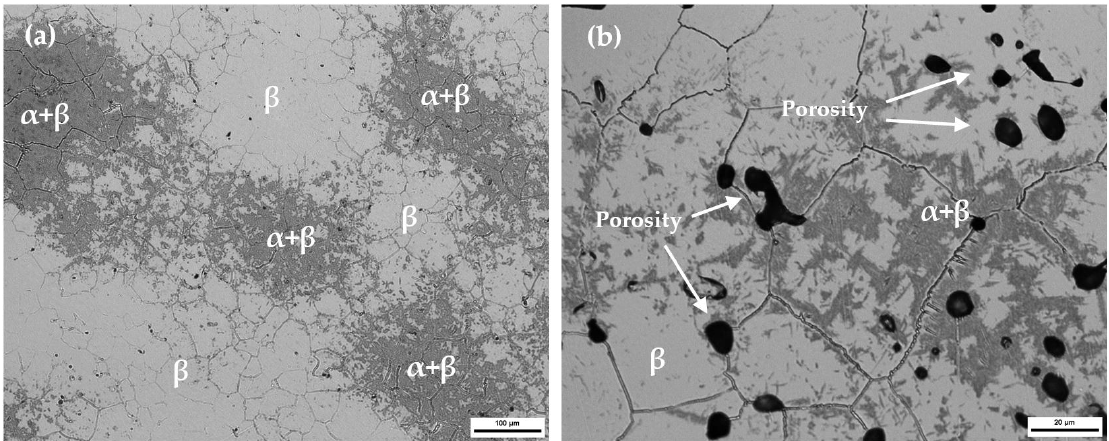
Figure 1. Microstructure of the P/M Ti35Nb10Ta alloy ( a ) Heterogenous phase composition; ( b ) α + β region.